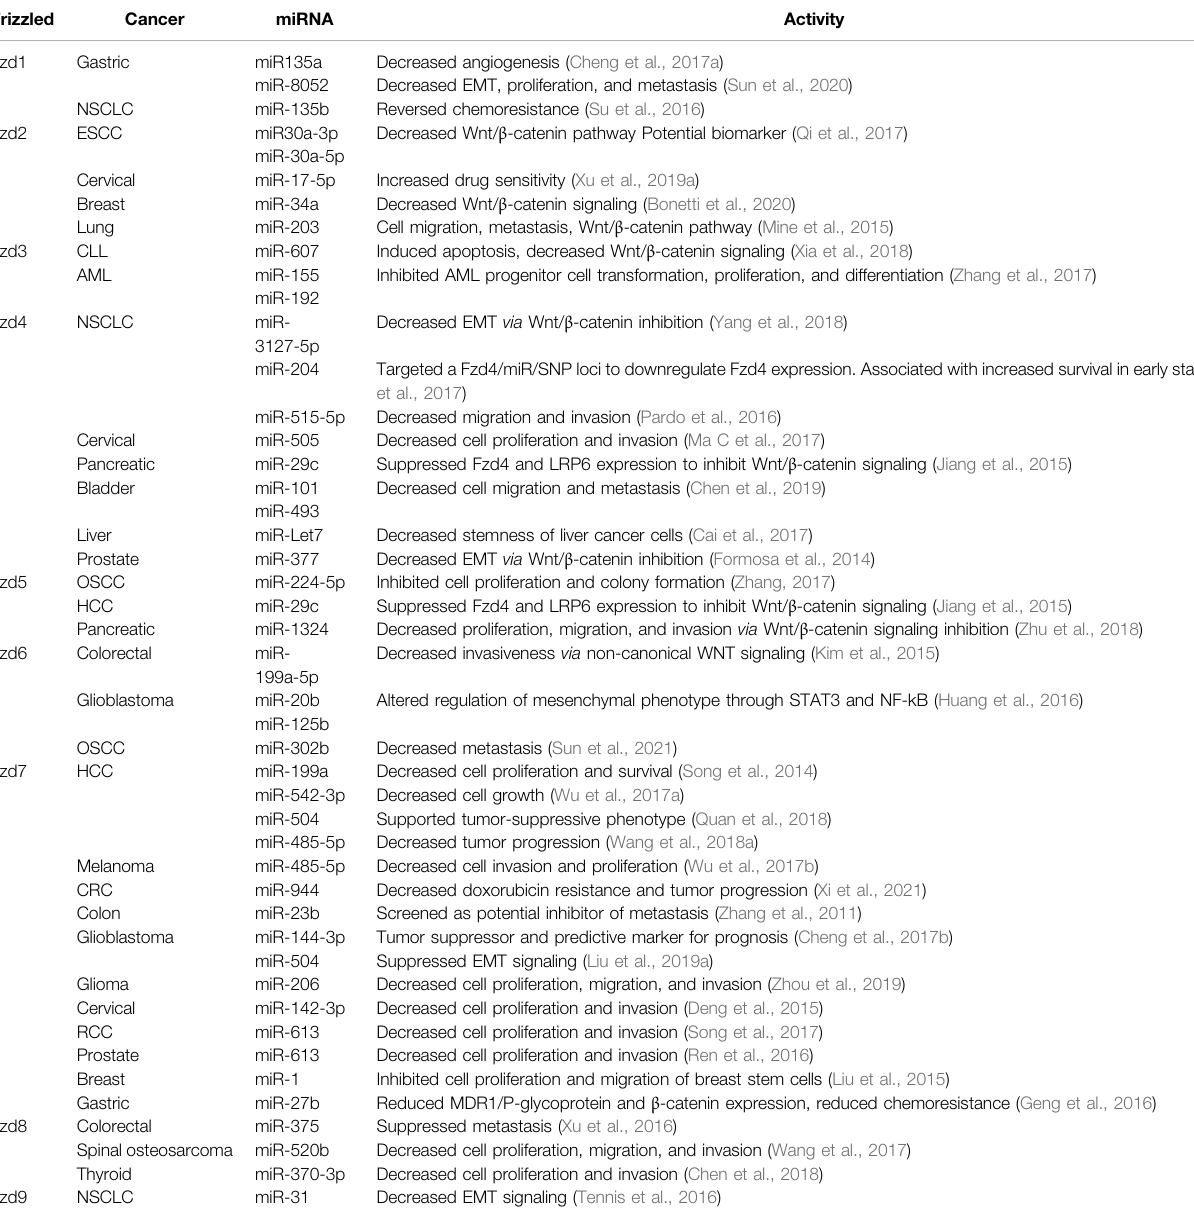
TABLE 1 | Frizzled receptors and associated miRNA in cancer. Frizzled Cancer miRNA